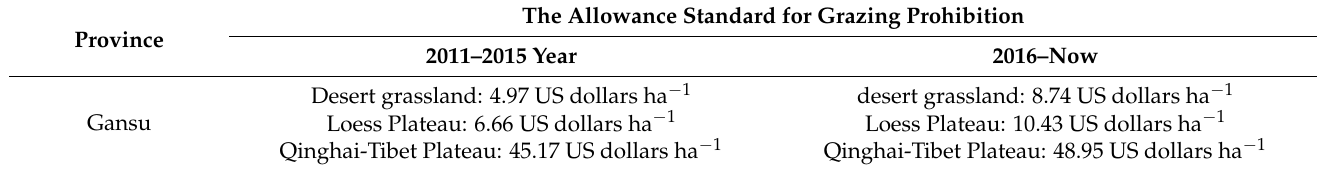
Table A6. Two phases of the subsidy and incentive standards of the SISGC for grazing